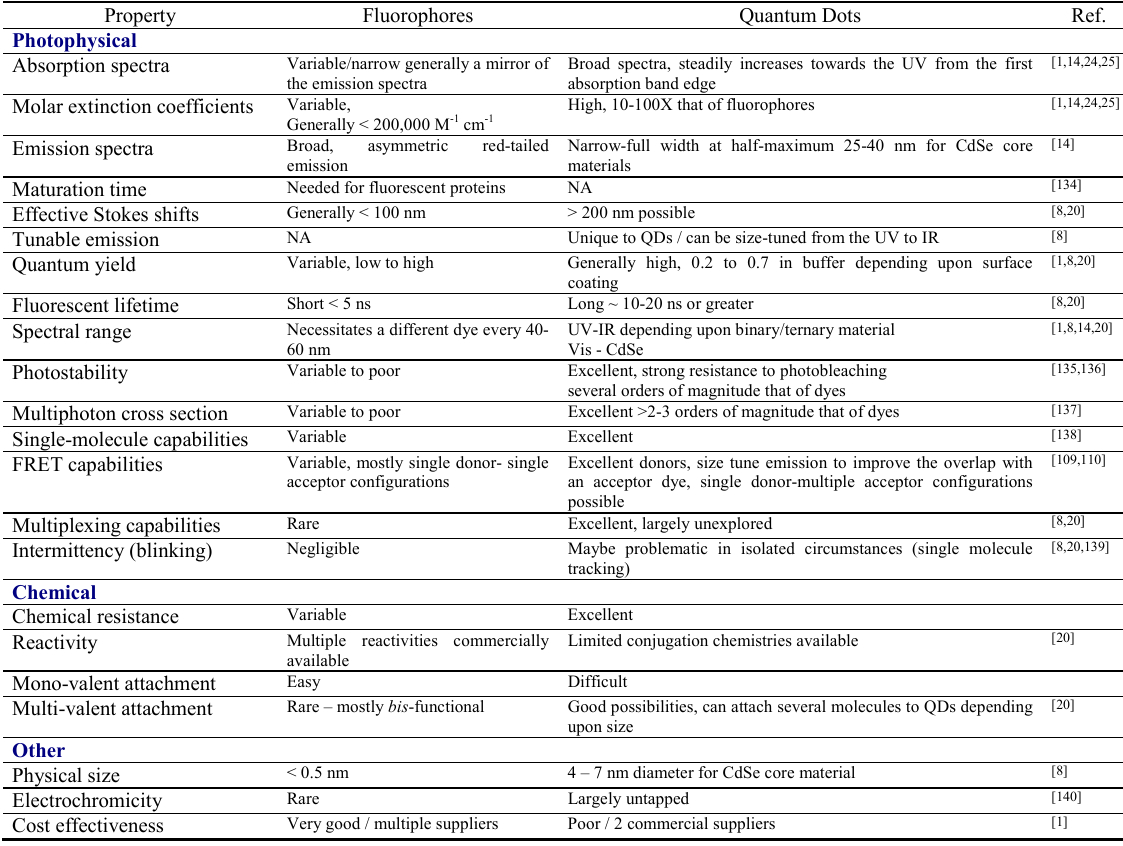
Table I. Comparison of organic/protein fluorophore and quantum dot properties